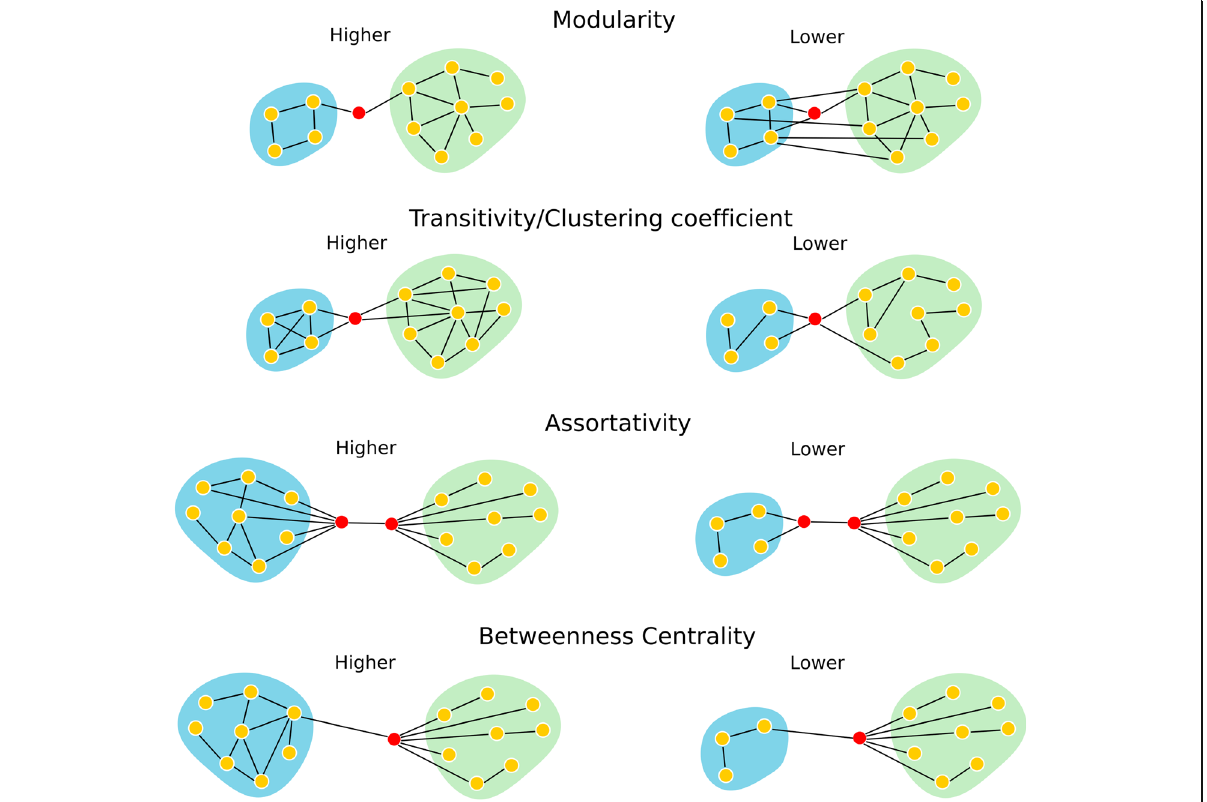
Fig. 1 Simplistic illustration of the network measures used in the study. Higher assortativity illustrating the tendency of a high degree node to be connected to another higher degree node; higher transitivity shows the greater number of connections within the module (forming triangles, higher modularity illustrates the reduced inter-module connection between the network, and higher betweenness centrality displays node connecting two networks with large number of within module connections highlighting the importance of this node in the